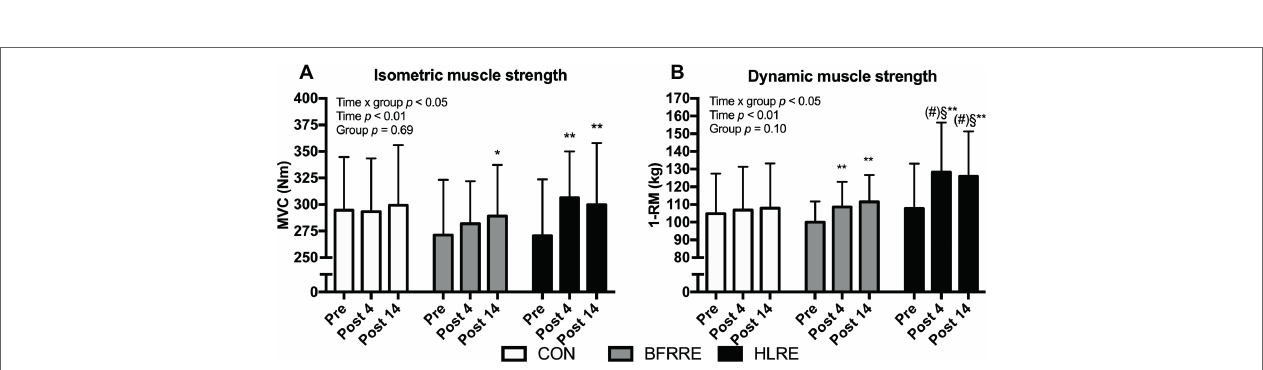
FIGURE 8 | Isometric muscle strength (A) and dynamic muscle strength (B) at baseline (pre), 4 days after cessation of training (post 4), and 14 days after cessation of training (post 14). Data are presented as mean ± SD. Overall effects are given in the upper left corner of graphs. * p < 0.05 and ** p < 0.01 different from pre within group; § p < 0.05 different from BFRRE within time-point; (#) p < 0.1 tendency toward difference to CON within